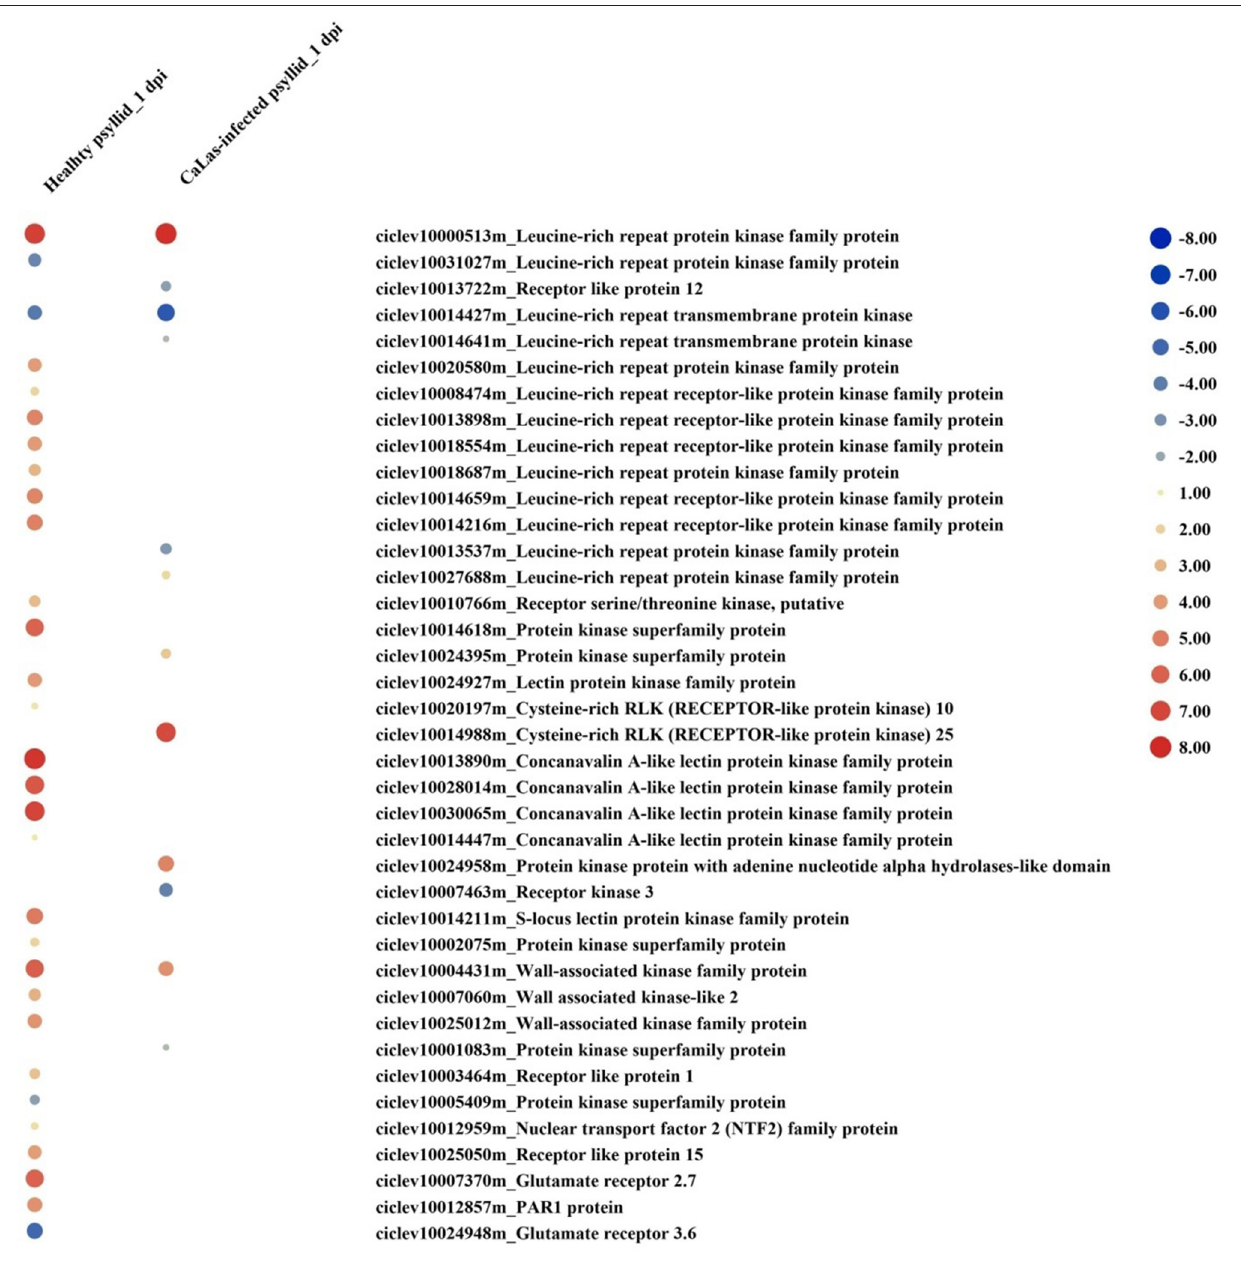
( Figure 5 ). Notably, a member of the MAP Kinase Kinase family (ciclev10021170m), which has been shown to be independently involved in ethylene biosynthesis, was upregulated in VAL under healthy psyllid infestation at 1